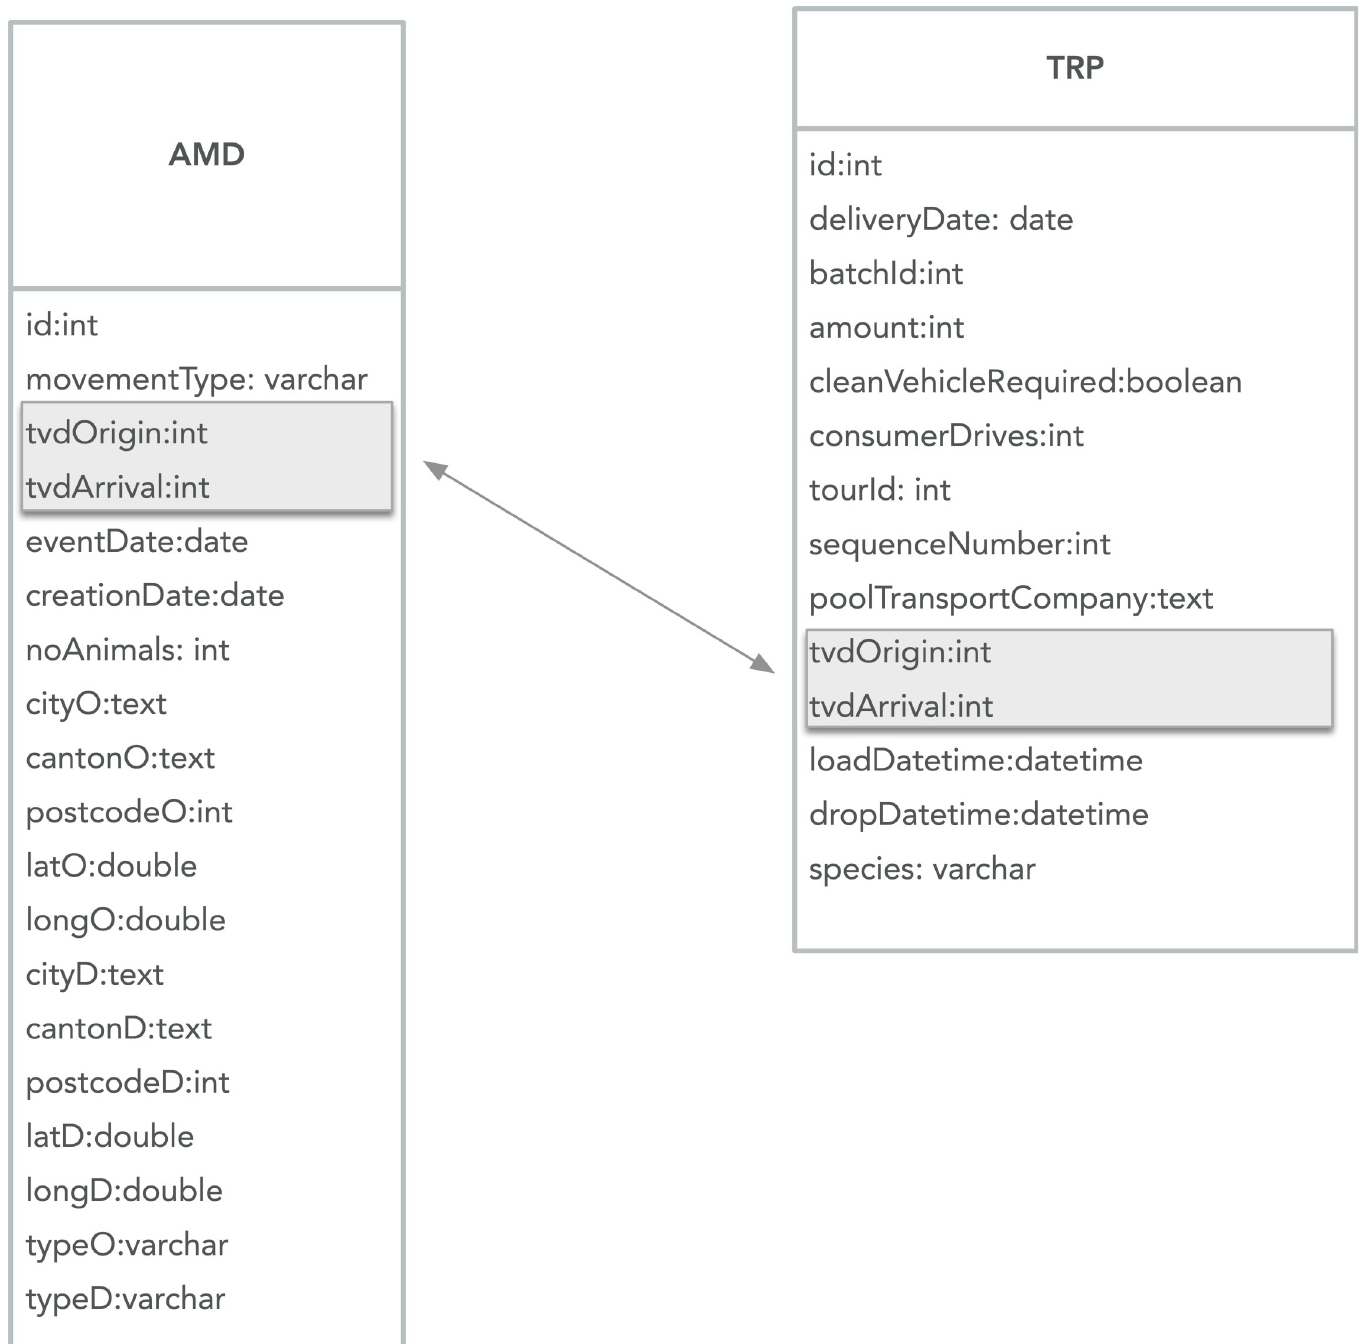
Fig 1. Graphical representation of the raw data we collected from AMD (on the left) and TRP (on the right) . The matching of movements is based on the attributes tvdOrigin (integer) and tvdArrival (integer) in both data sets.